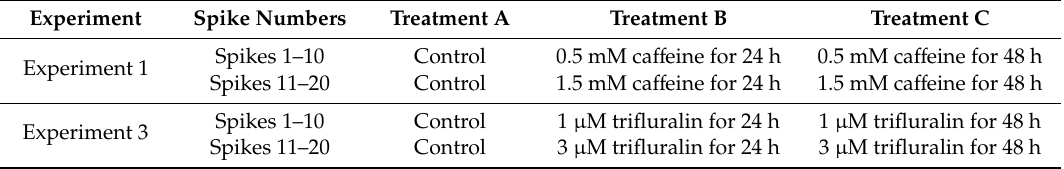
Table 7. Ca ff eine and trifluralin treatments for Experiments 1 and 3. Anthers were exposed to the chemicals at the start of the induction